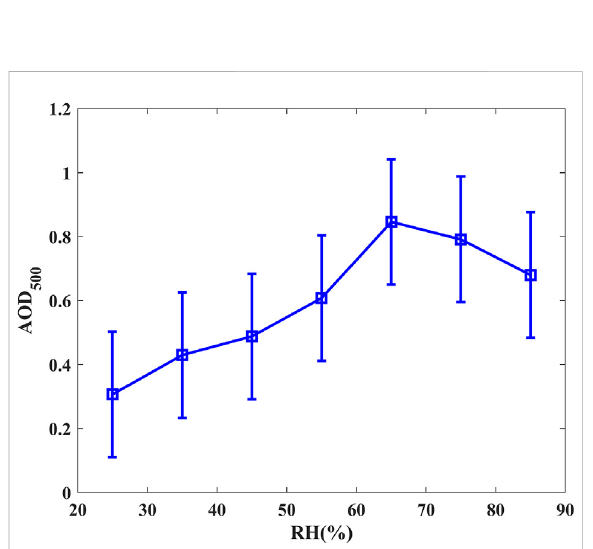
FIGURE 8 Seasonal mean aerosol volume size distributions for spring (red), summer (blue), autumn (green) and winter (black) at XAUT